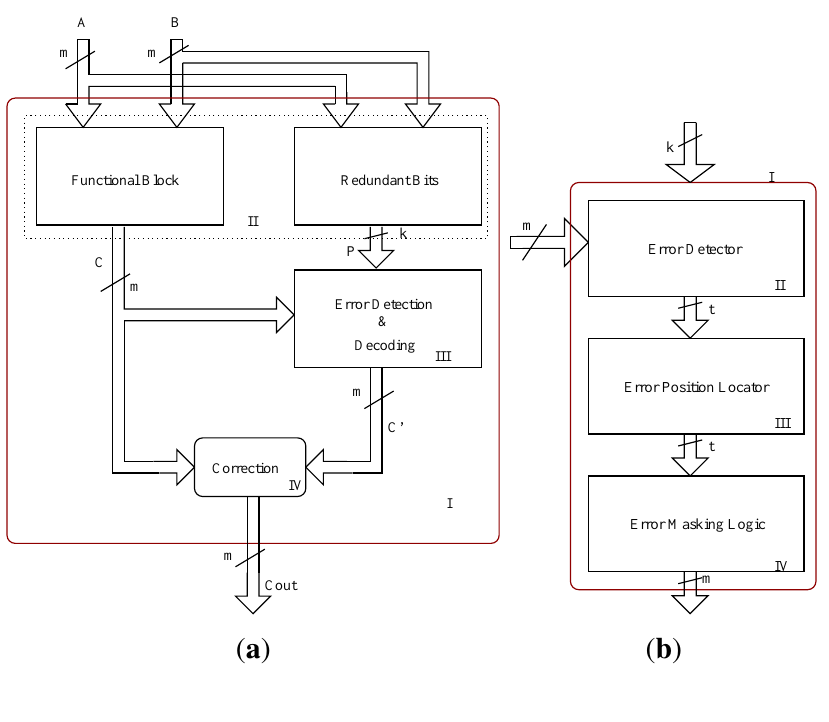
Figure 1. BCH code based multiple detection and correction architectures. ( a ) Multiple error correction architecture; ( b ) Error detection and correction block.